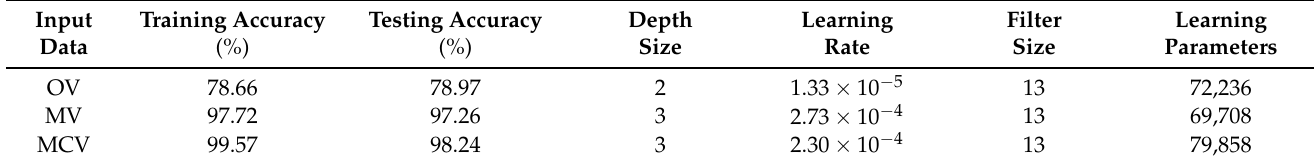
Table 5. Training results for CNN strategy.